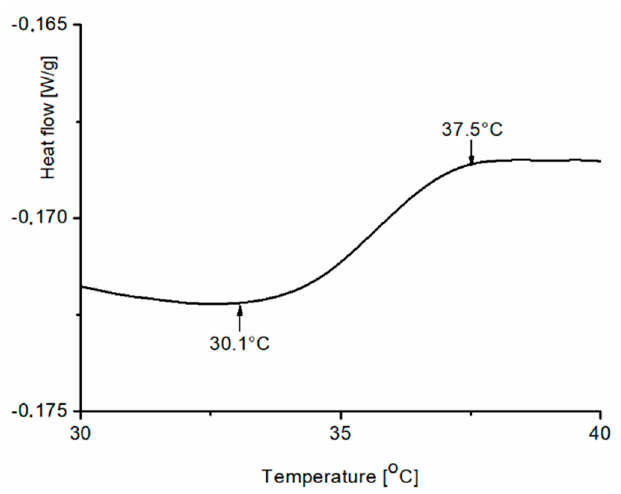
Figure 9. The heating DSC thermogram for an aqueous solution of PNPS2 (0.5% w / w ), heating rate of 1 K/min.